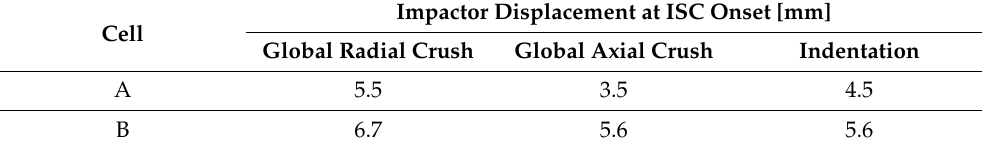
Table 5. Comparison of the impactor displacement at ISCR onset for cell A and cell B in the three tested configurations at cell level.